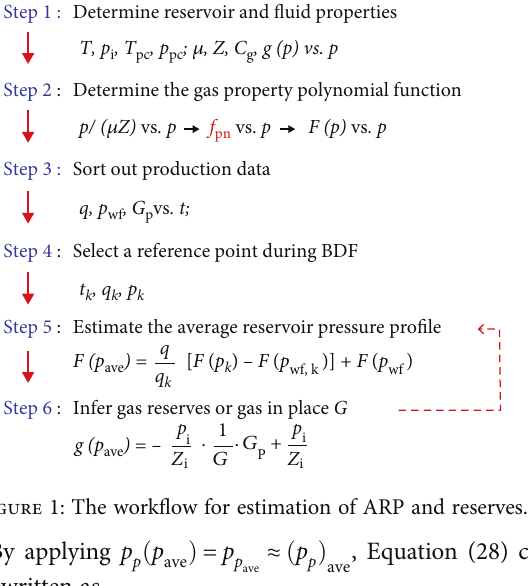
Figure 1: The work fl ow for estimation of ARP and reserves.